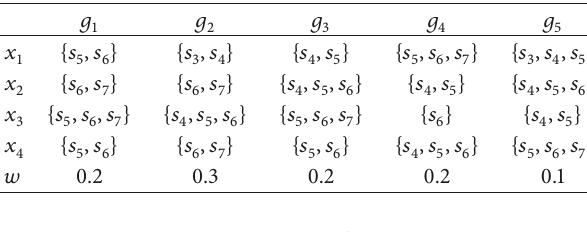
Table 9: Hesitant fuzzy linguistic information matrix 𝐿 [4].